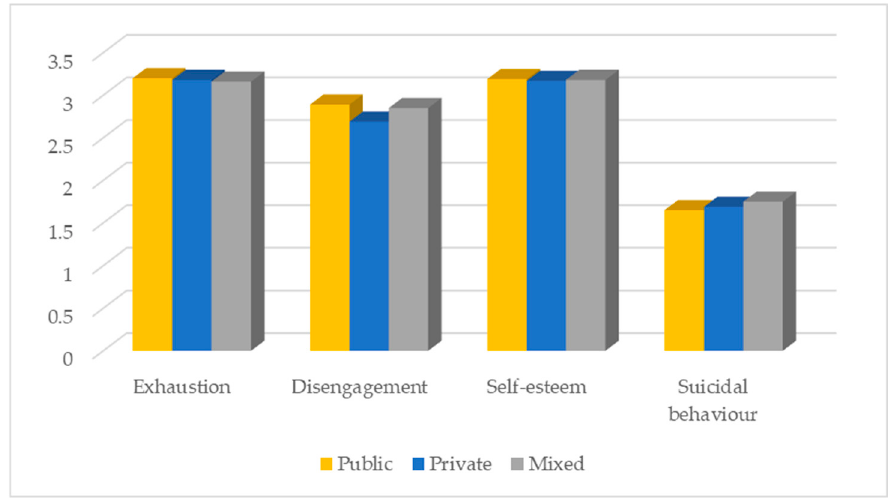
Figure 6. Distribution of the variables under study according to the sector